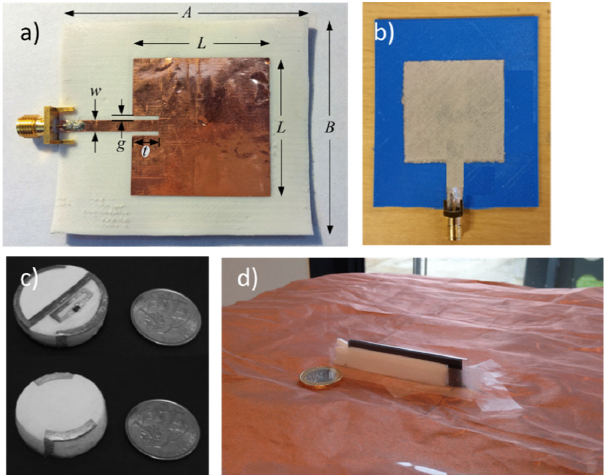
Figure 7. Examples of D printed antennas. ( a ) Square patch antenna on NinjaFlex substrate (dimensions in mm A = 65, B = 55, L = 35.8, w = 3, g = 1, t = 7) [107], ( b ) brush-painted wearable antenna on a 3-D printed substrate [112], ( c ) button-shaped 3-D radio-frequency identification (RFID) tag antenna [111], and ( d ) 3-D printed flexible inverted-F antenna (IFA) [113]. The radiator of the antenna was brush-painted from the stretchable silver conductive paste (Figure 7b). The antenna’s wireless performance under flat and bending conditions was satisfactory.